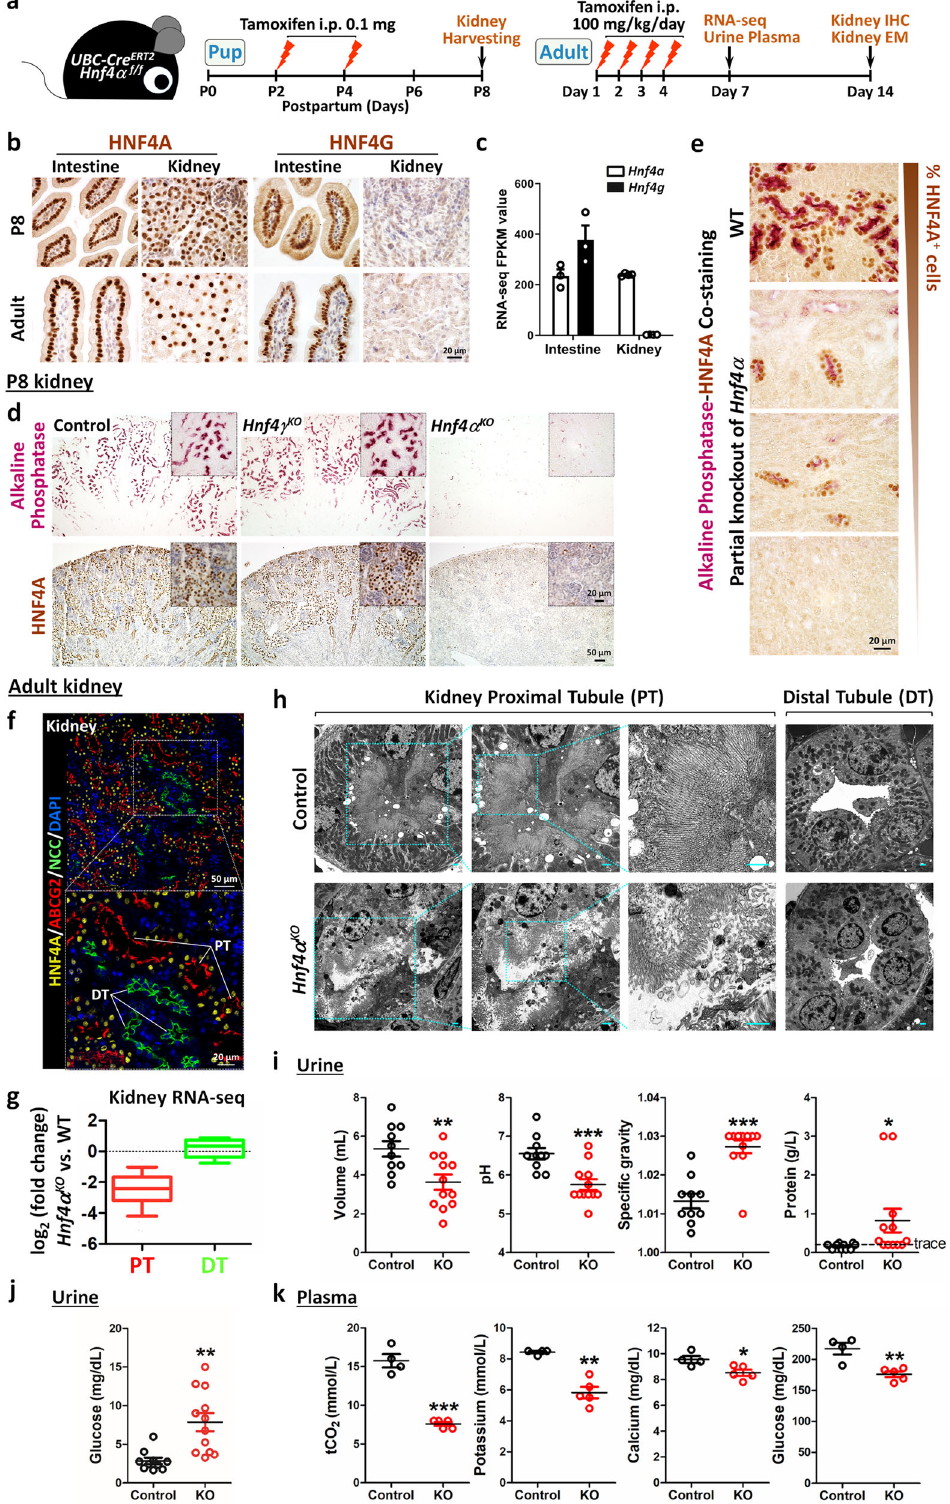
during embryonic development. To achieve a higher fraction of HNFA4-negative yolk sac tissues and assay for yolk sac functions, we treated pregnant mice with a mixture of tamoxifen and pro- gesterone at E12.5 and E13.5 (Fig. 5e). We found that Hnf4 α KO embryos showed reduced size (Fig. 5f) and weight (Fig. 5g) compared to their Cre -negative littermate controls, suggesting